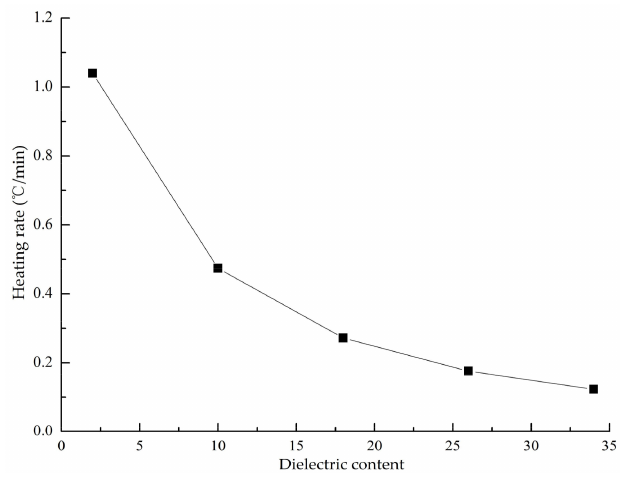
Figure 7. The graph of dielectric constant and heating rate.